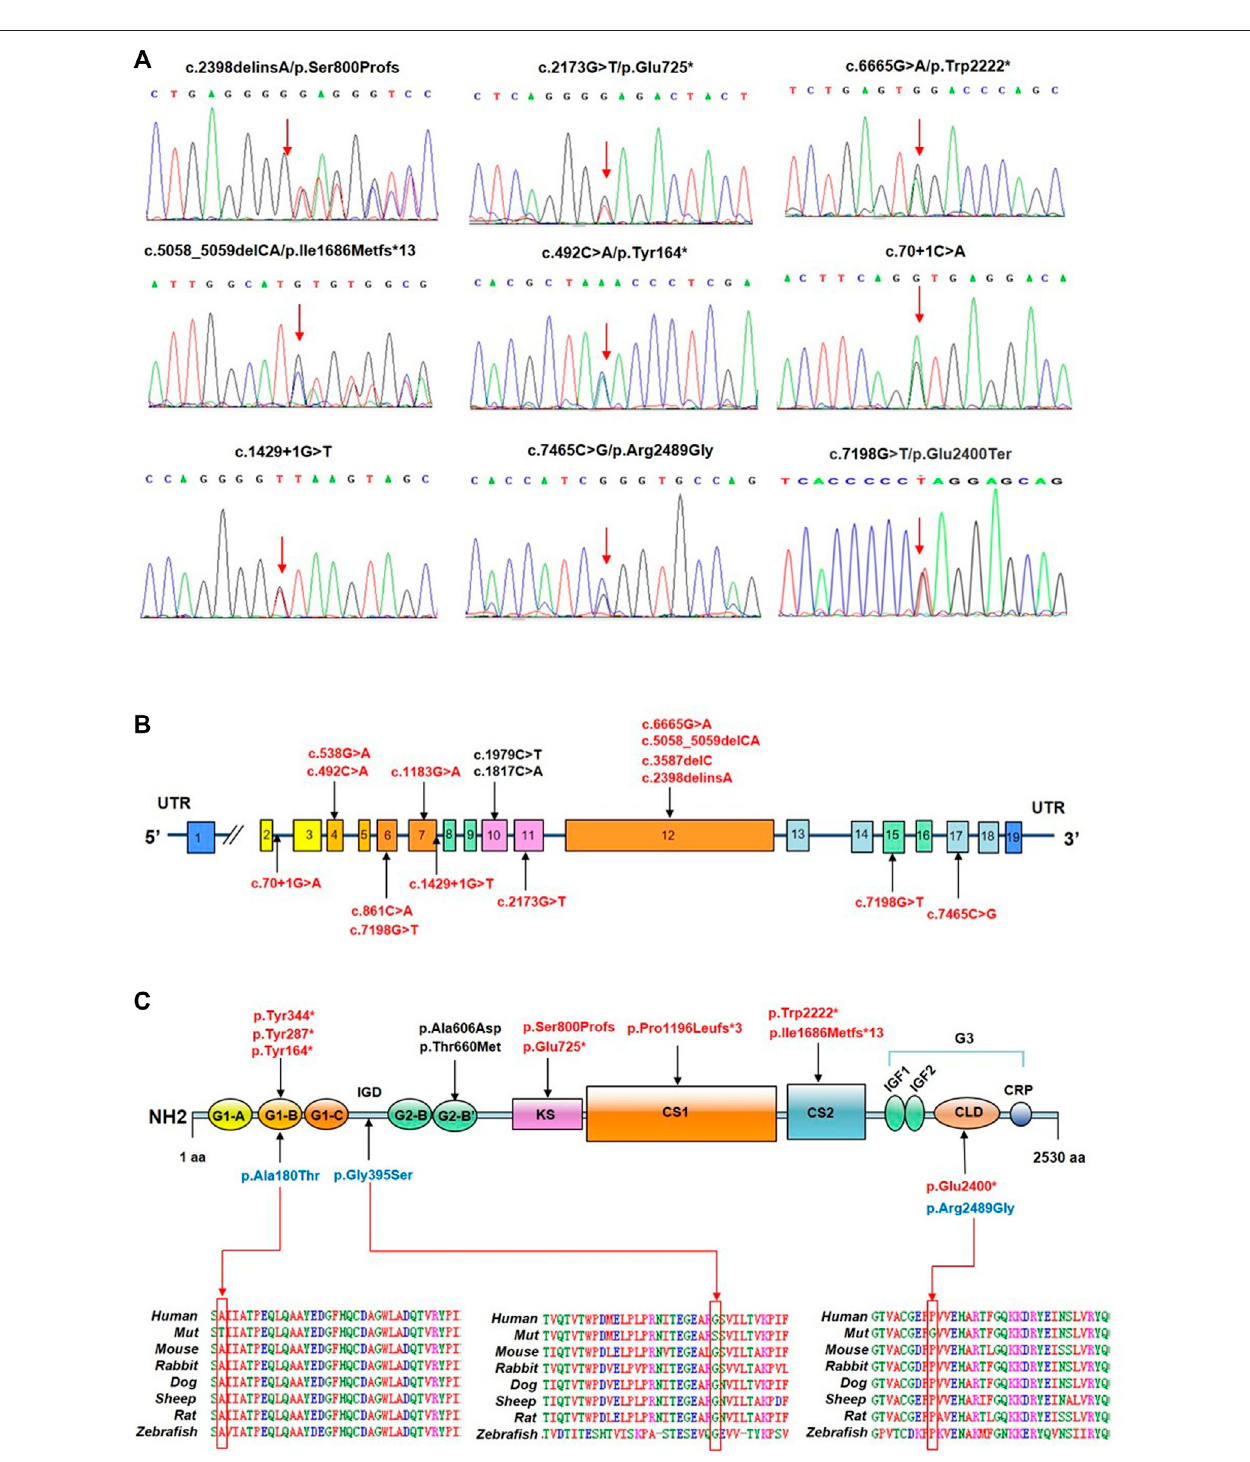
FIGURE 1 | Identi fi cation of ACAN variants in patients with short stature. (A) Sequence chromatograms of ACAN variants as detected. (B) Distribution of ACAN variants inexonsandintrons. (C) ACAN mutationsarelocatedincorrespondingdomains. Abbreviations:G1,globulardomain1;IGD,interglobular domain;G2,globular domain 2; KS, keratan sulfate; CS1, chondroitin sulfate 1; CS2, chondroitin sulfate 2; G3, globular domain 3; EGF1, 2, epidermal growth factor-like domain 1, 2; CLD, C-type lectin domain; CRP domain, complement regulatory protein-like domain. The red arrow is pointing at orthologous and paralogous protein alignments showing the high conservation of each amino acid altered by three missense variants from humans to zebra fi sh.